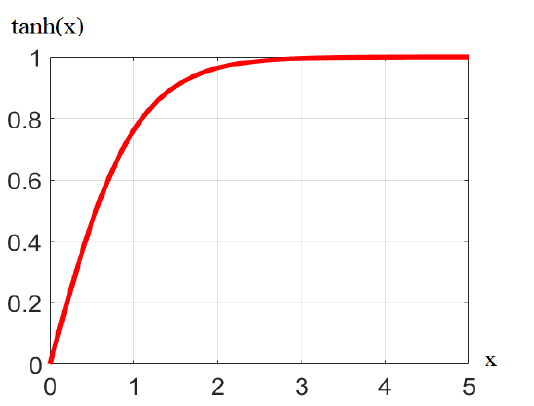
Figure 3. Schematic diagram of the hyperbolic tangent function. Table 1. Weights of three carrying indexes Stage of urbanization